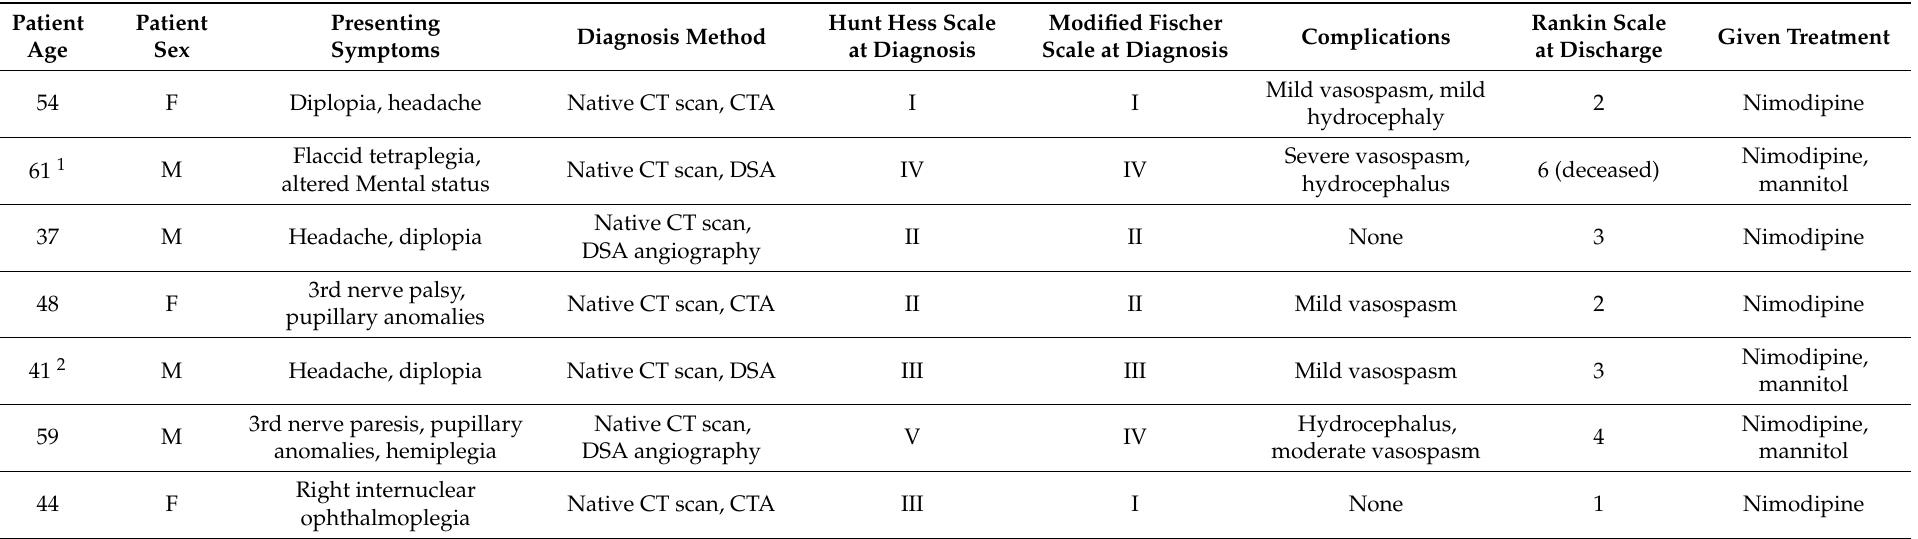
Table 1. An overview of the patients diagnosed and treated in our